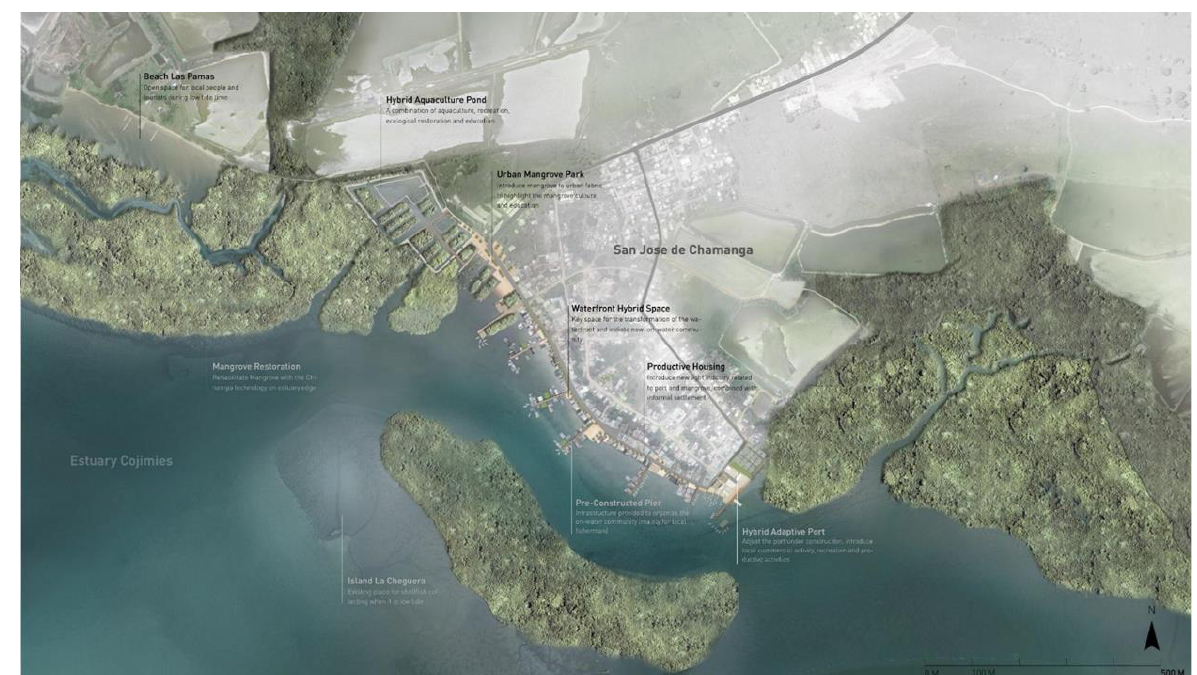
Figure 8. Informal Armature © Shuwen Ye and Aubrey Jahelka.